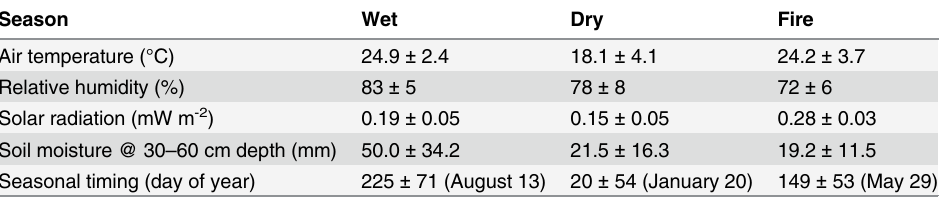
All values are mean ± 1 standard deviation.